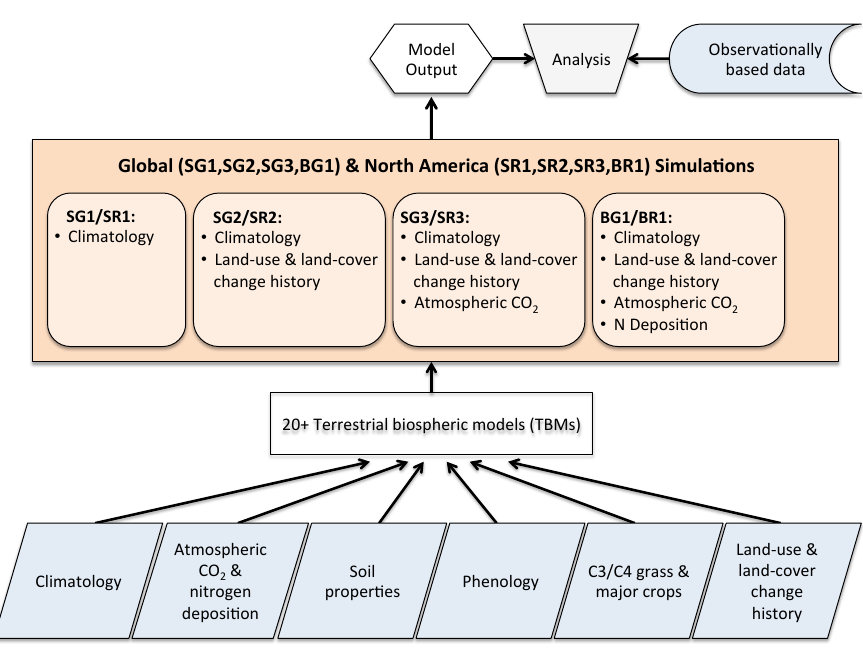
Fig. 1. Schematic of the Multi-Scale Synthesis and Terrestrial Model Intercomparison Project (MsTMIP) framework. Global simulations (SG1,SG2, SG3,BG1) are run at 0.5 ◦ by 0.5 ◦ resolution; North American simulations (SR1, SR2, SR3, BR1) are run at 0.25 ◦ by 0.25 ◦